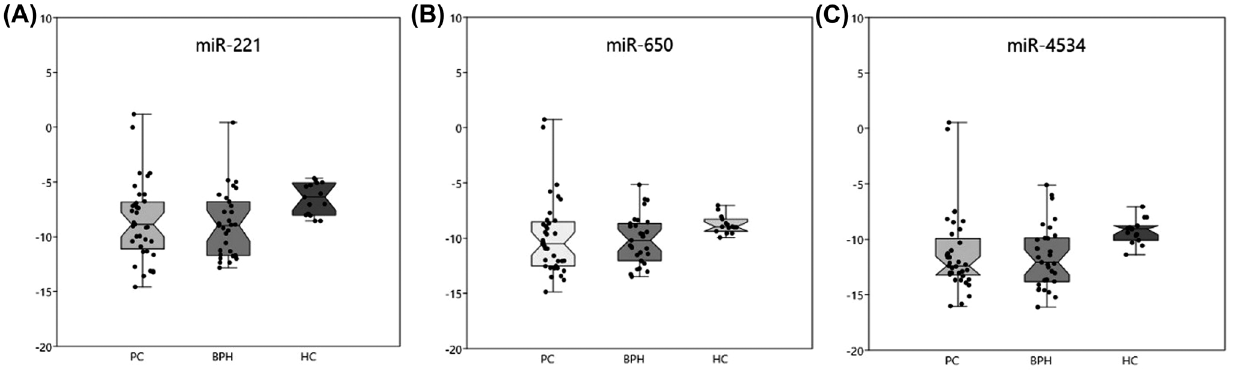
Figure 1: Differential expression of miR-221 (A), miR-650 (B) and miR-4534 (C) in PCa, BPH and HC. The expression levels are examined by real-time QPCR and calculated using Δ Ct method. Presented data are the mean ± SD.